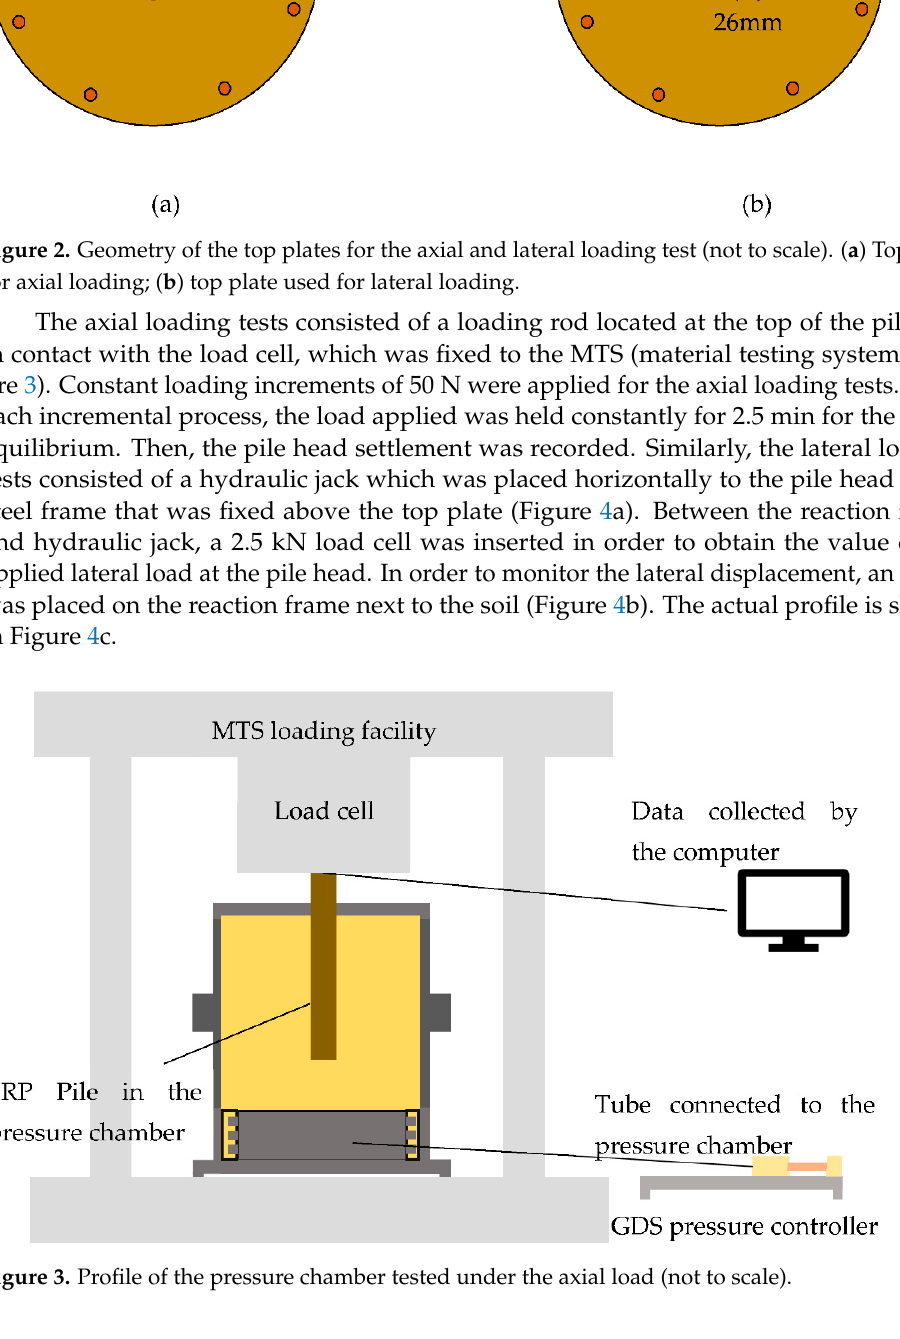
Figure 1. Illustration and dimensions of the setup tested in the laboratory connected to the GDS controller and computer (not to scale).